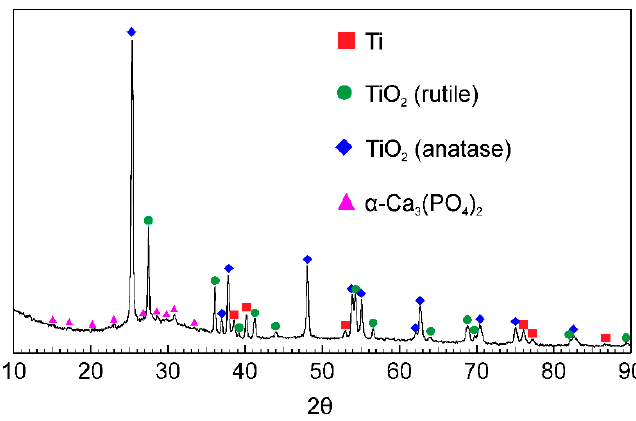
Figure 3. XRD patterns PEO-coating.